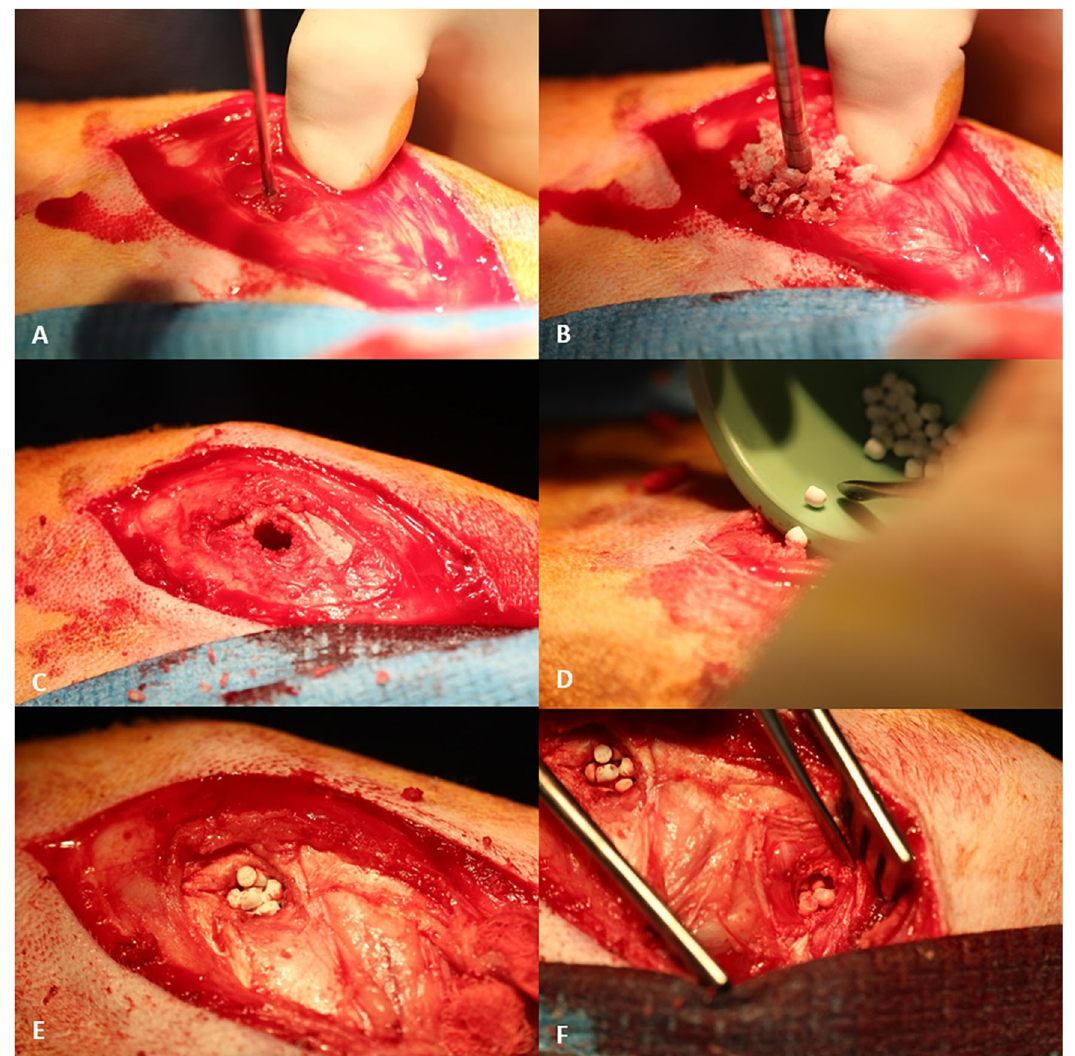
Fig. 2 a – f Representation of the surgical procedure and the implantation of the test materials. Cylindrical defects of 11 mm in diameter and 20 mm deep were placed with a cannulated surgical acorn drill bit bilaterally in the cancellous bone within the epiphyseal region of the proximal tibia and distal femur in each sheep. The test/control materials were implanted, and the wounds closed in a routine